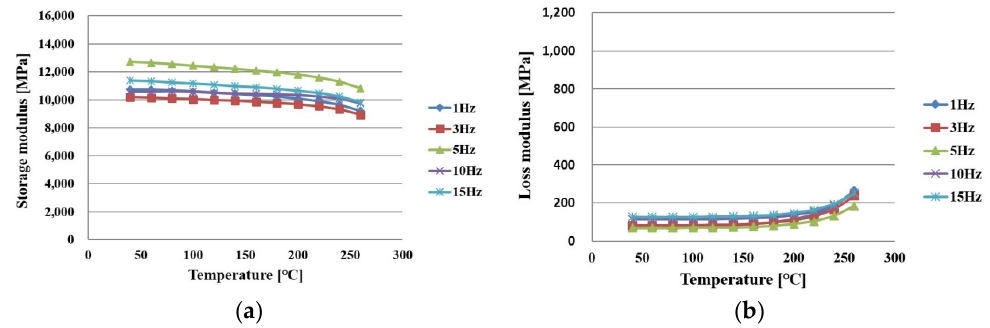
Figure 8. Measurement results of PPG in an x direction after being cured as a function of frequency: ( a ) storage modulus; ( b ) loss modulus.